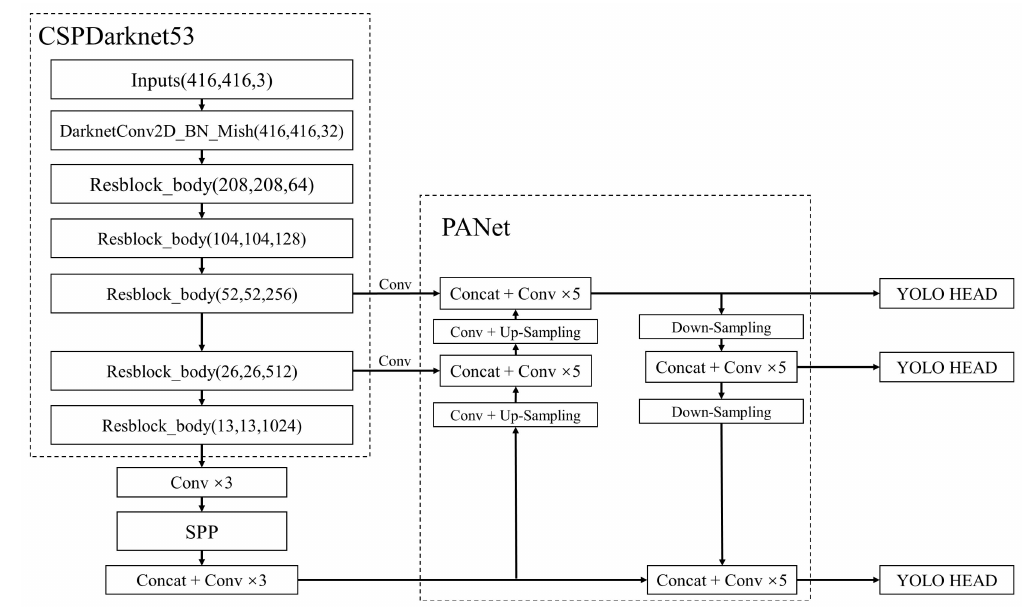
Figure 1. The overall network structure of